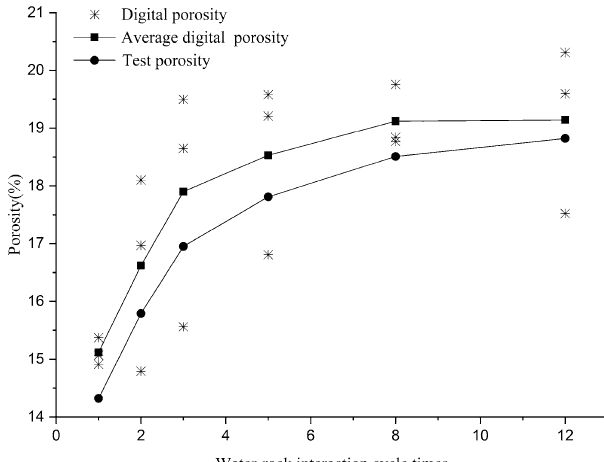
Figure 10. Porosity variation rule of the pores by water–rock